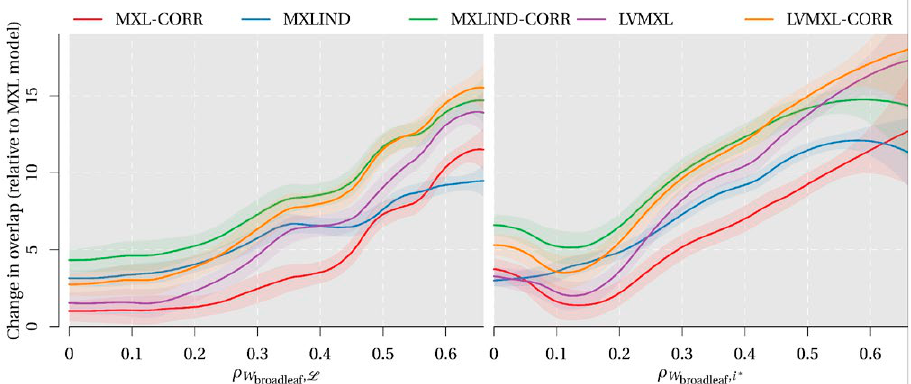
Figure 2. Percentage point difference in overlap of MWTP distributions relative to the true MWTP dis- tribution for